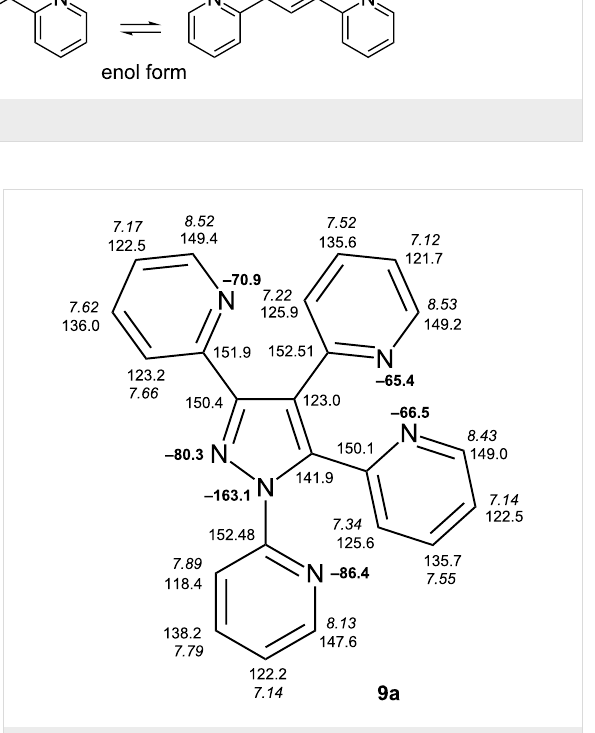
Figure 1: 1 H NMR (in italics), 13 C NMR and 15 N NMR (in bold) chemi- cal shifts of compound 9a (in CDCl 3